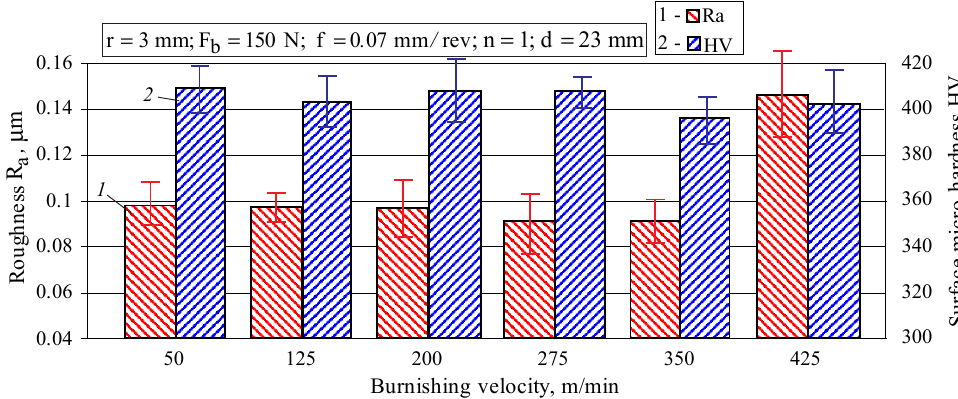
Figure 9. Effect of the burnishing velocity on the roughness parameter R a and surface micro-hardness.